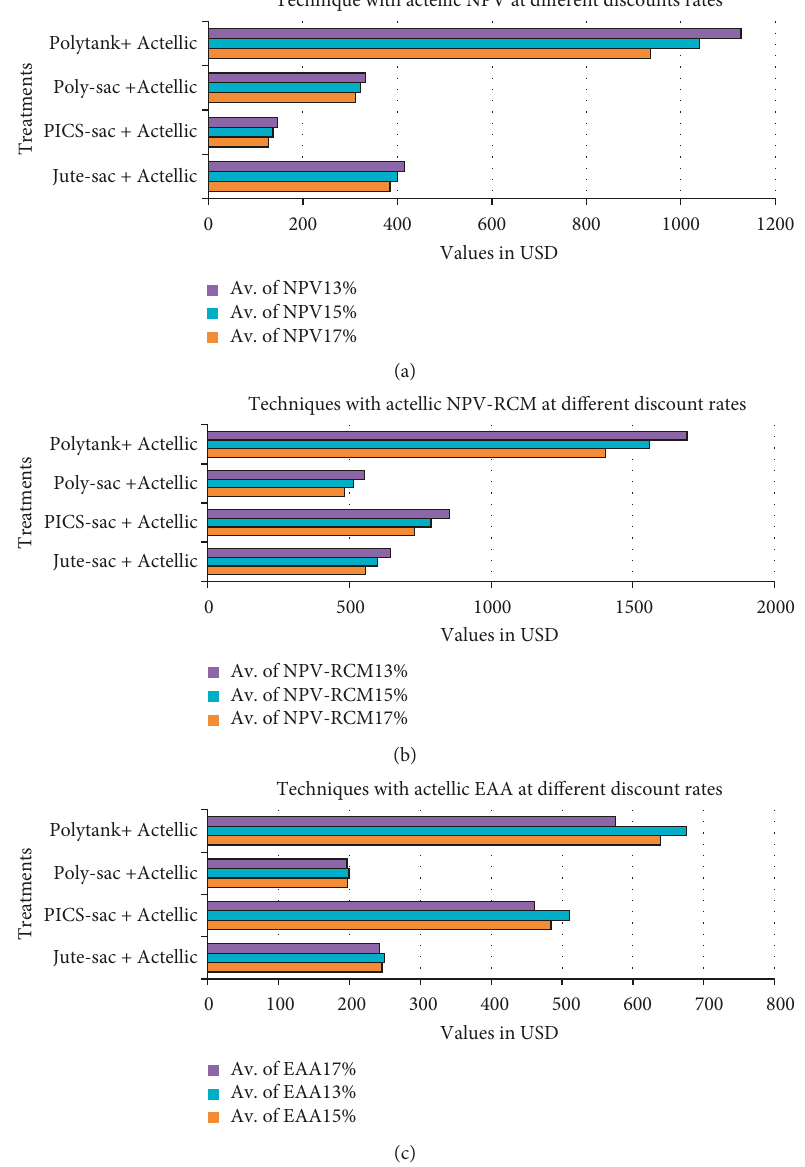
Figure 5: Performance of storage techniques treated with Actellic Supper in maize